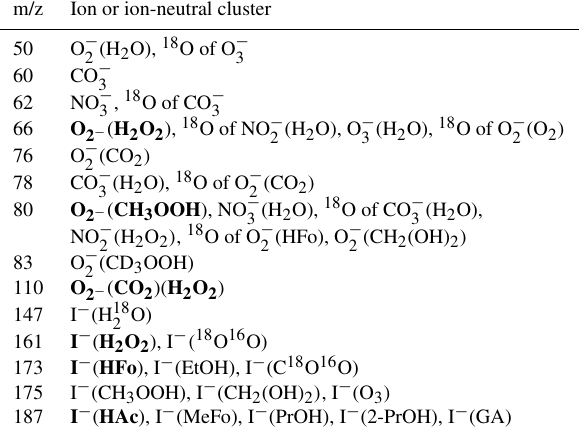
Table 1. PCIMS m/z for species clusters of interest and potential isobaric interfering ions or ion clusters at the mass resolution of the quadrupole mass selector. Bold font indicates a primary PCIMS an- alyte ion cluster mass; “ 18 O of” indicates one of the ion cluster’s oxygen atoms is a mass 18 isotope of oxygen; in CD 3 OOH the D represents deuterium atoms; EtOH refers to ethanol; PrOH refers to 1-propanol; 2-PrOH refers to 2-propanol; CH 2 (OH) 2 refers to methane-diol; MeFo refers to methyl formate; and GA refers to hy- droxy acetaldehyde (a.k.a.